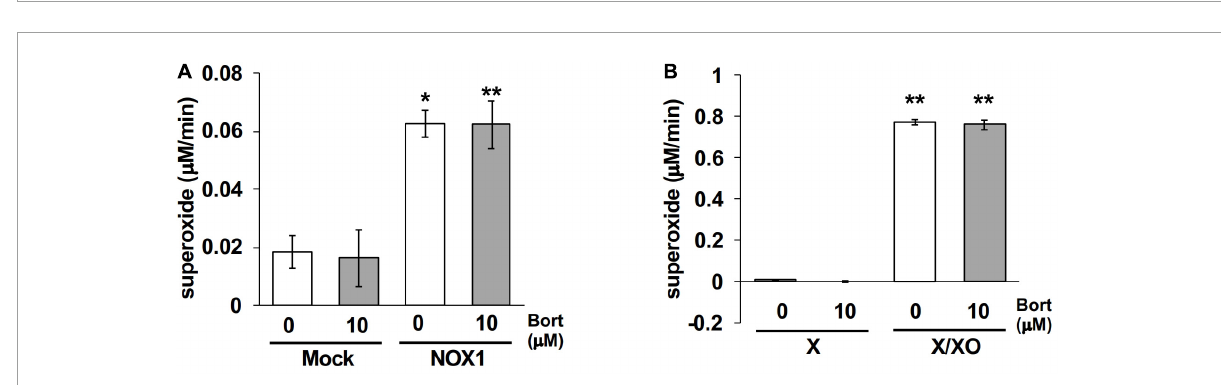
FIGURE6 Bortezomib-induced enhancement was not observed in the cytochrome c reduction assay. The levels of SOD-inhibitable reduced cytochrome c in the supernatant of NOX1-expressing cells [ (A) , 1 × 10 5 cells/0.1 ml] and of the X/XO system [ (B) , 5 mU/ml XO]. The concentration of cytochrome c and X was 0.1 and 0.2 mM, respectively. The absorbance was measured at 30 min after the 37 ◦ C reaction and expressed as optical density at a wavelength of 550 nm and a reference wavelength of 670 nm. N = 3. Data were from two independent experiments,